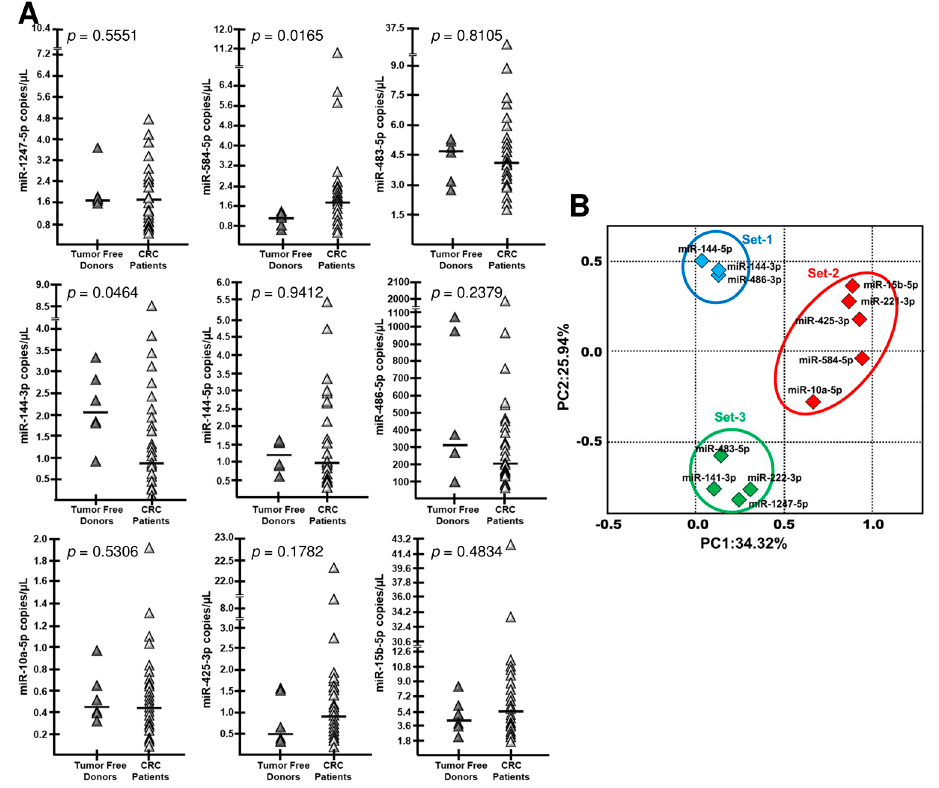
Figure 5. Digital droplet RT-PCR validation and principal component analysis (PCA). ( A ): Digital droplet RT-PCR validation (dd-RT-PCR) comparing plasma samples from 35 CRC patients and 6 tumor-free donors with respect to the content of dysregulated miRNAs. ( B ): PCA captured the variation observed in the experiment in the first three principal components (PC). Three principal microRNA sets on the basis of their respective correlations can be proposed, as depicted in the panel. The nine miRNAs of the proposed signature, plus the miR-141-3p, miR-221-3p and miR-222-3p, were considered.